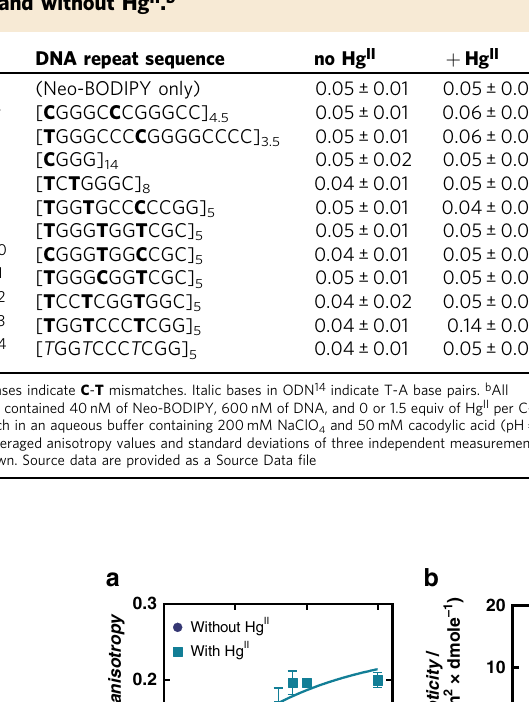
Table 2 DNA hairpin repeat sequences a and fl uorescence anisotropy of Neo-BODIPY in the presence of each DNA with and without Hg II . b